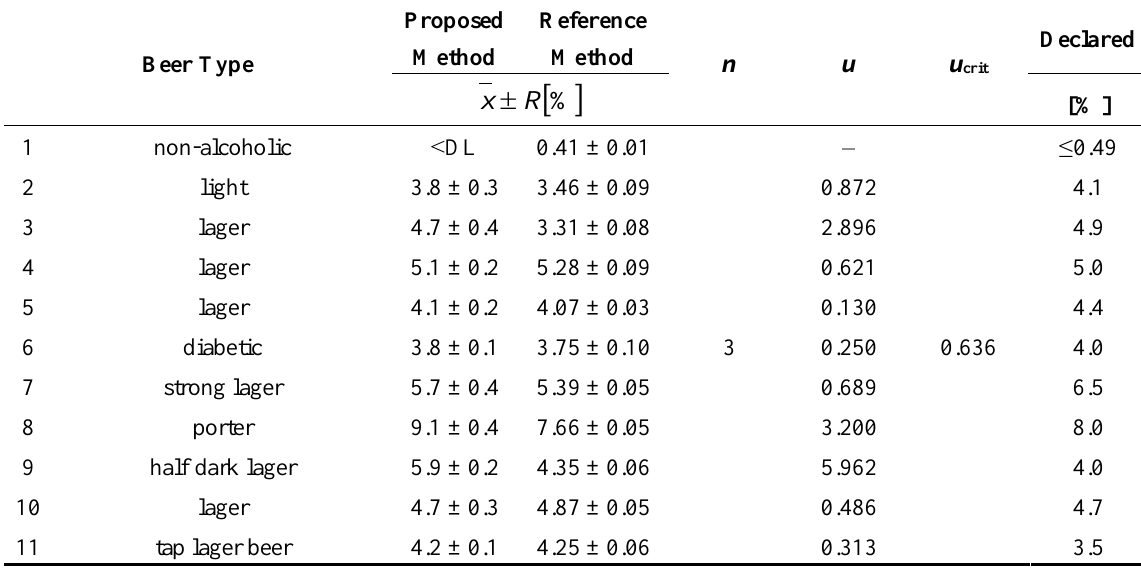
Table 1. Determination of ethanol content in real beer